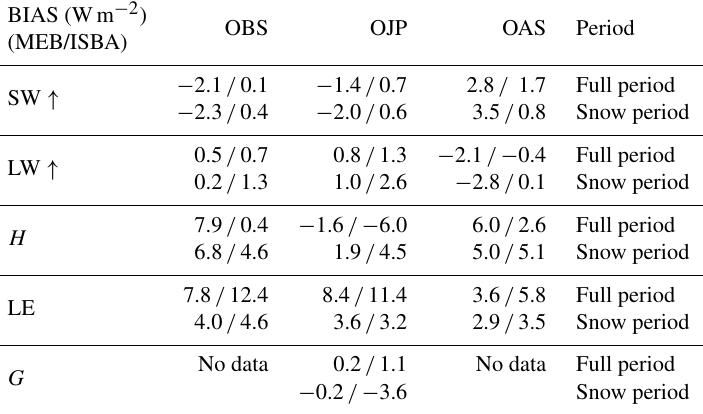
Table 4. BIAS for the ISBA-MEB and ISBA experiments for fluxes SW ↑ , LW ↑ , H , LE, and G calculated over half-hourly